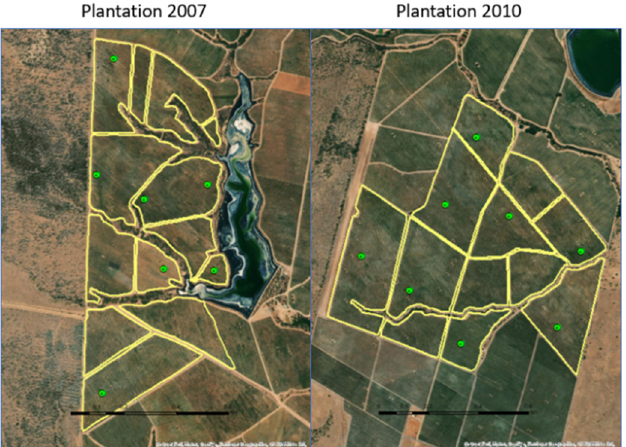
Figure 4. Spatial distribution of fruit samples (green dots). Polygons in yellow correspond to all Cabernet Sauvignon varieties. ArcMap Image.